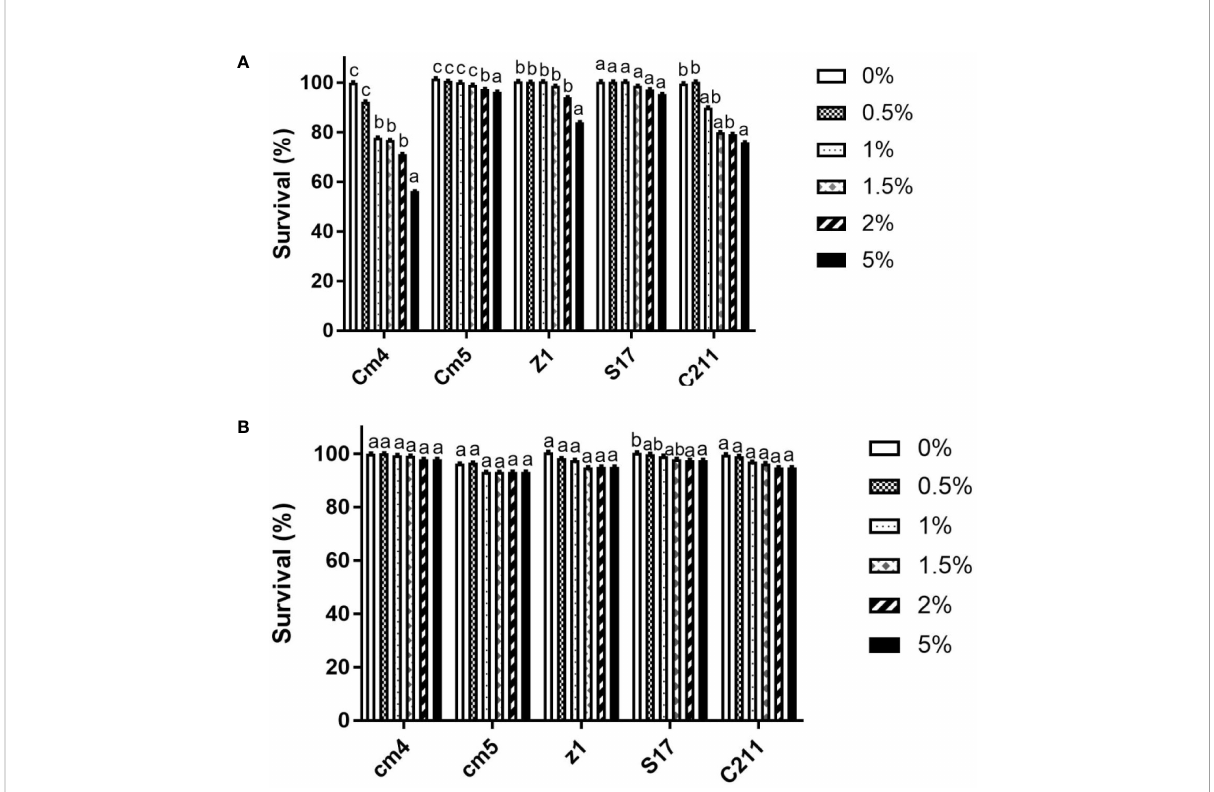
FIGURE 6 Tolerance of vegetative cells (A) and spores (B) at different bile concentrations for 3h at 28°C (log CFU/mL, SD*). Data are presented as (mean ± SD, n=3) with different superscript letters denoting a signi fi cant differences (p<0.05).